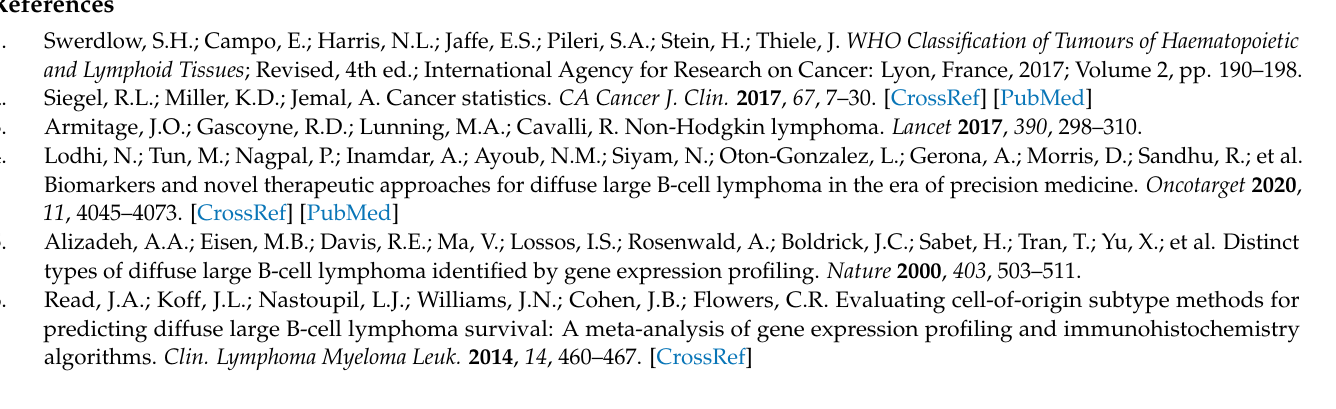
Table S2: Association of PD-L1+CD20+ % and PD-1+CD20+ % with the clinicopathological character- istics of post-therapy DLBCL